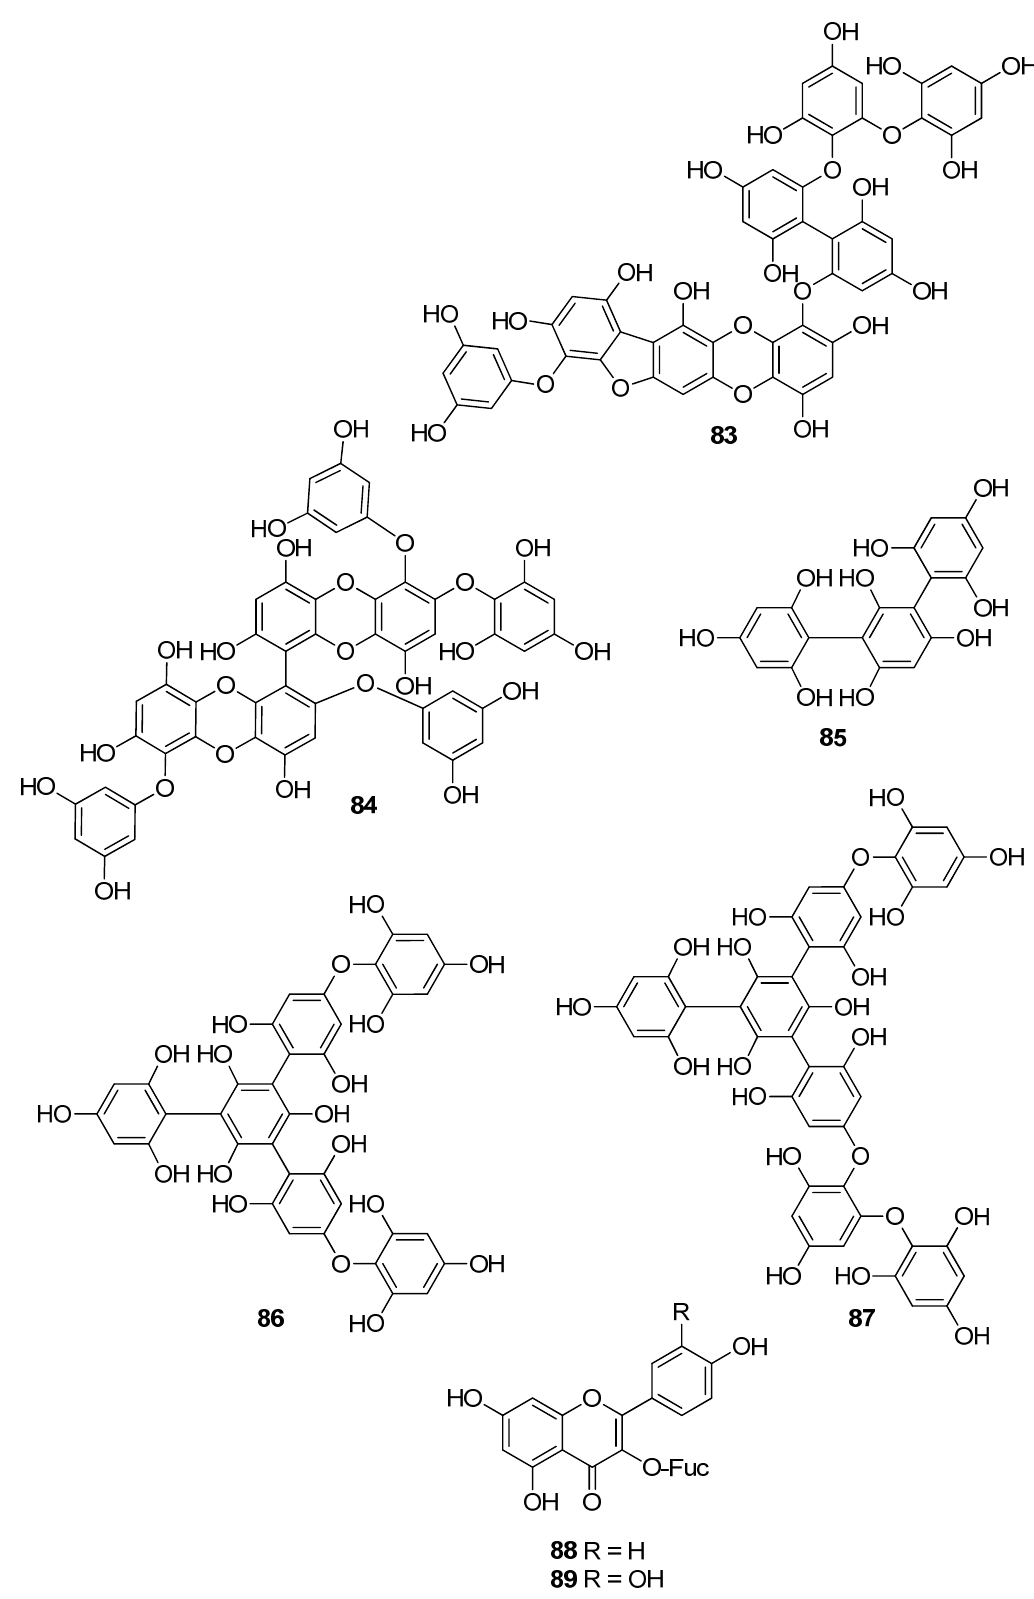
Figure 8. Chemical structures of compounds 83 – 89 .